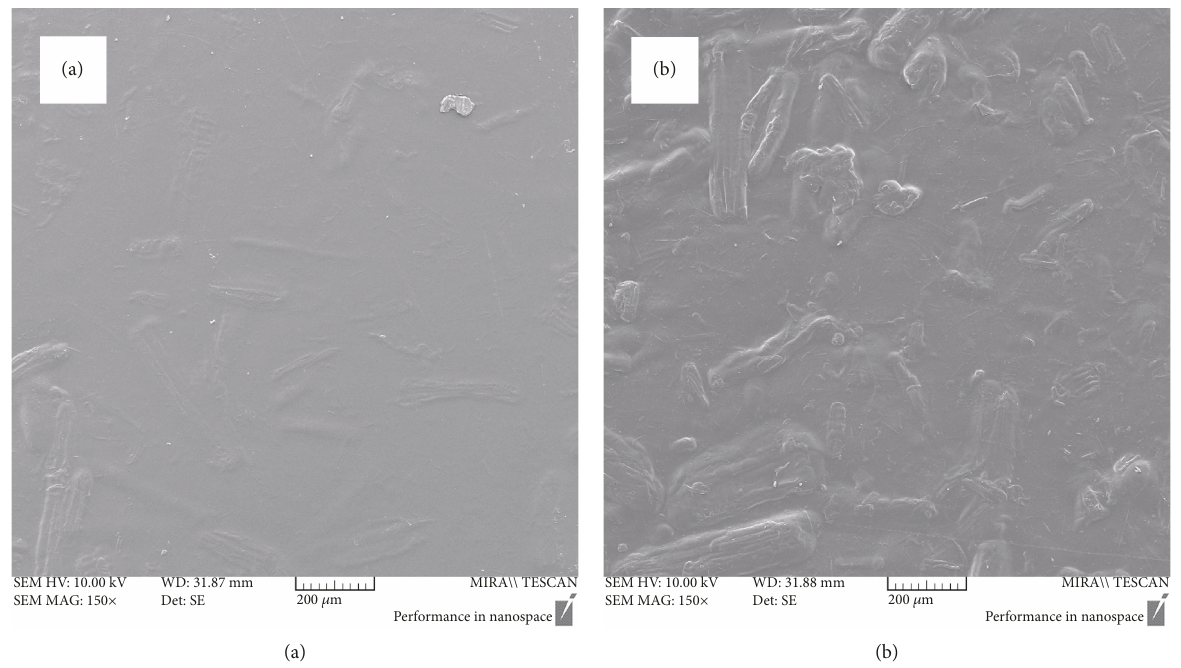
Figure 8: Surface morphology of biocomposites prepared using extracted wood as fi